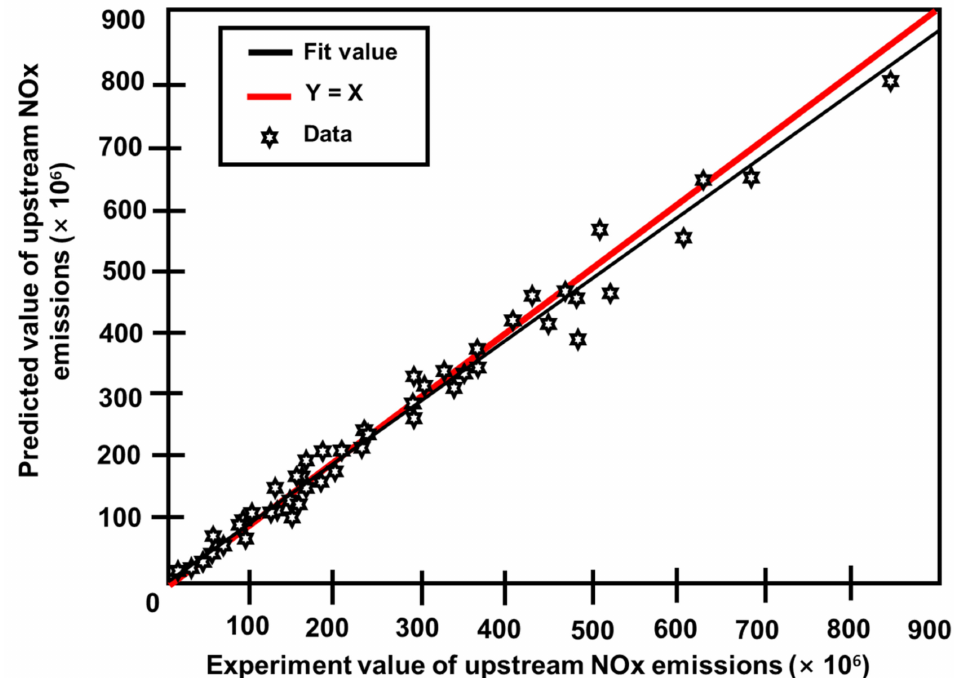
Figure 24. Comparison of experimental and projected NOx emissions from downstream source values